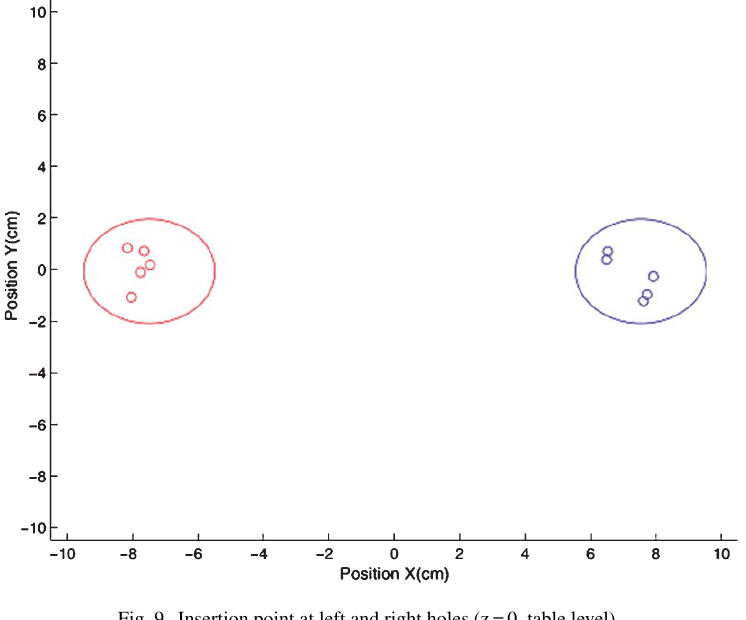
Fig. 9. Insertion point at left and right holes (z=0, table level).